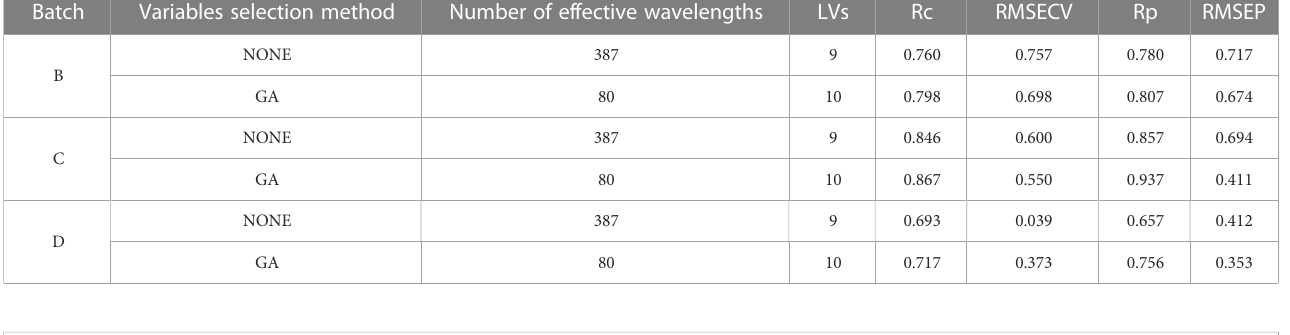
TABLE 4 Performance of the model based on GA method to measure the LC of batch B, C and D samples. Batch